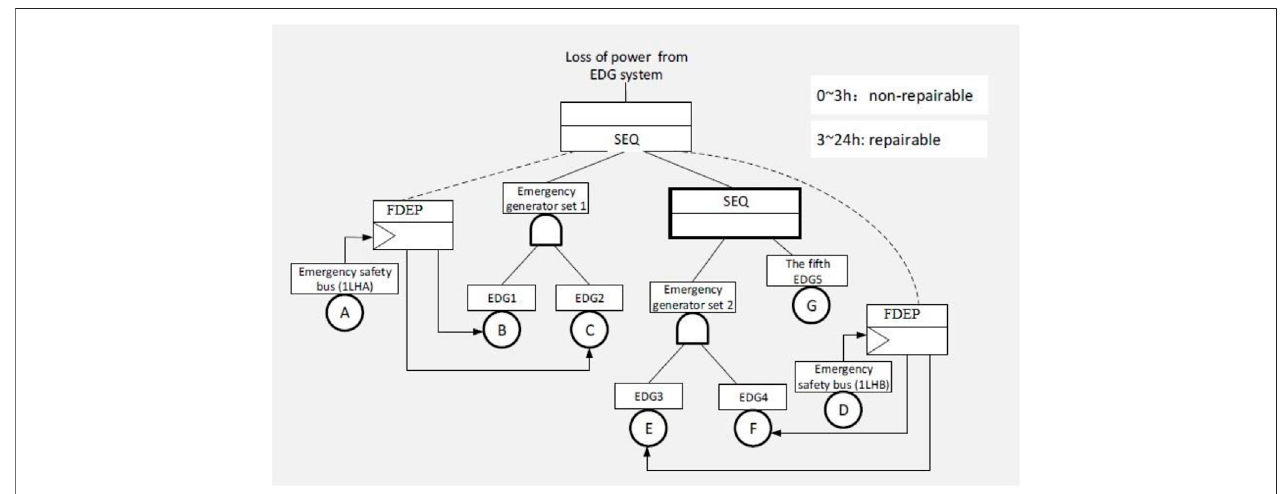
FIGURE 5 | DFT model of the